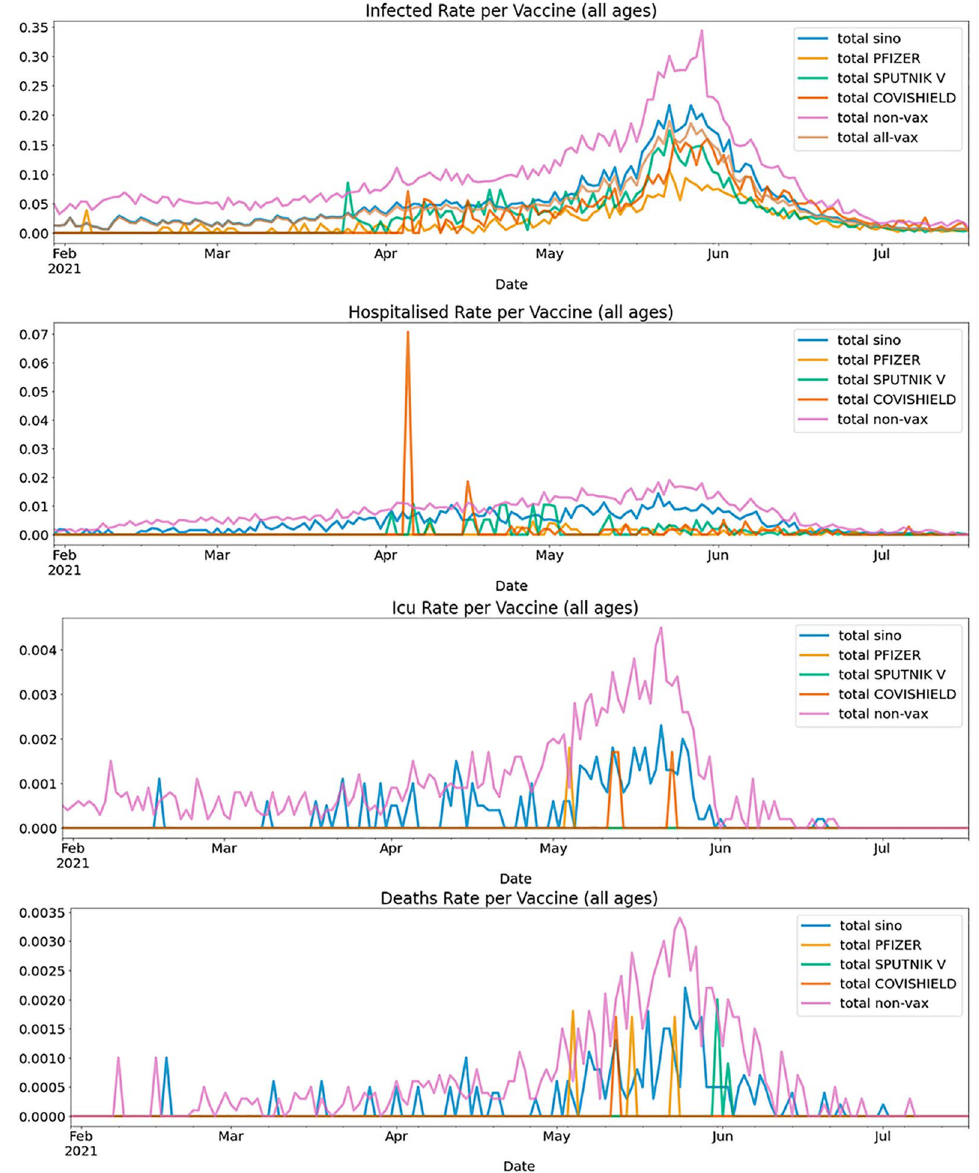
Figure 3. Timeline (events per person at risk per day) of infection, hospitalisations, ICU admissions and deaths for four vaccines compared to unvaccinated controls between Jan 30, 2021 to July 17,